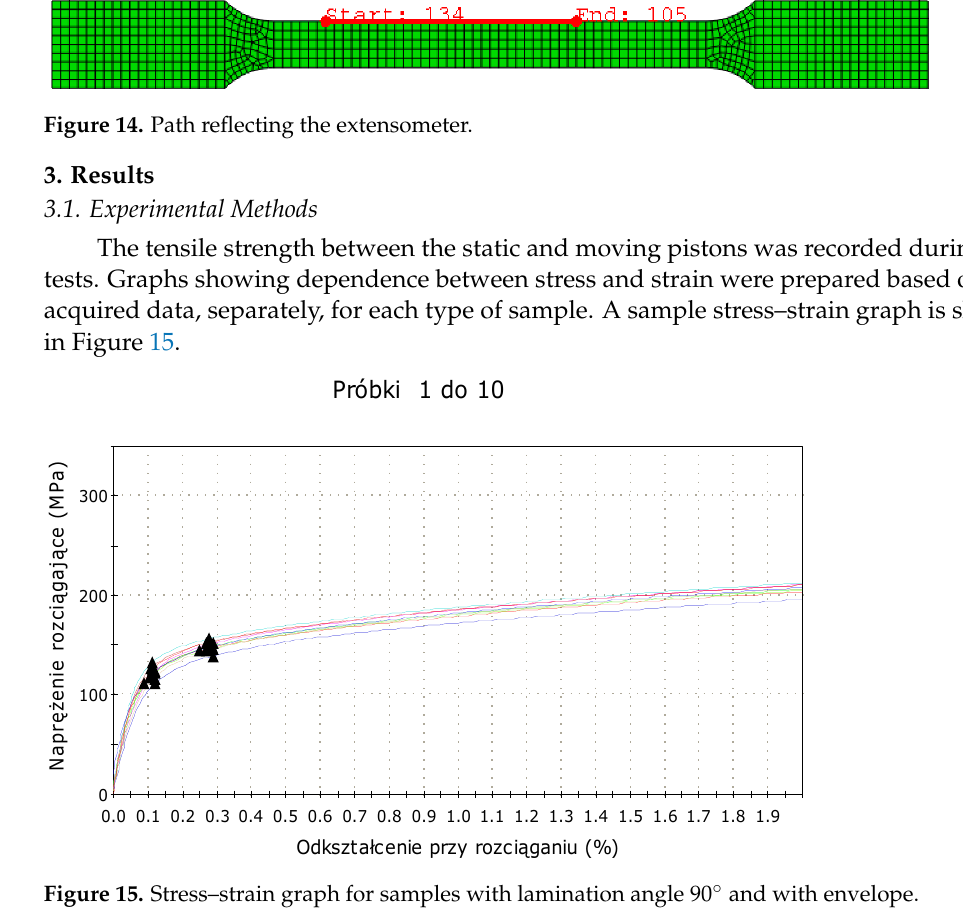
Figure 15. Stress–strain graph for samples with lamination angle 90 (cid:2925) and with envelope. Table 4. Data collected from static tensile strength for samples with lamination angle 90 (cid:3042) and en- velope